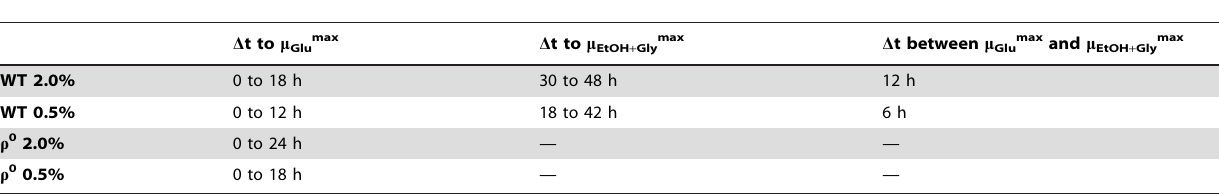
Table 1. Time intervals ( D t) used to calculate m Glumax , m EtOH + Glymax and ethanol and glycerol consumption after glucose exhaustion in WT and r 0 S. cerevisiae